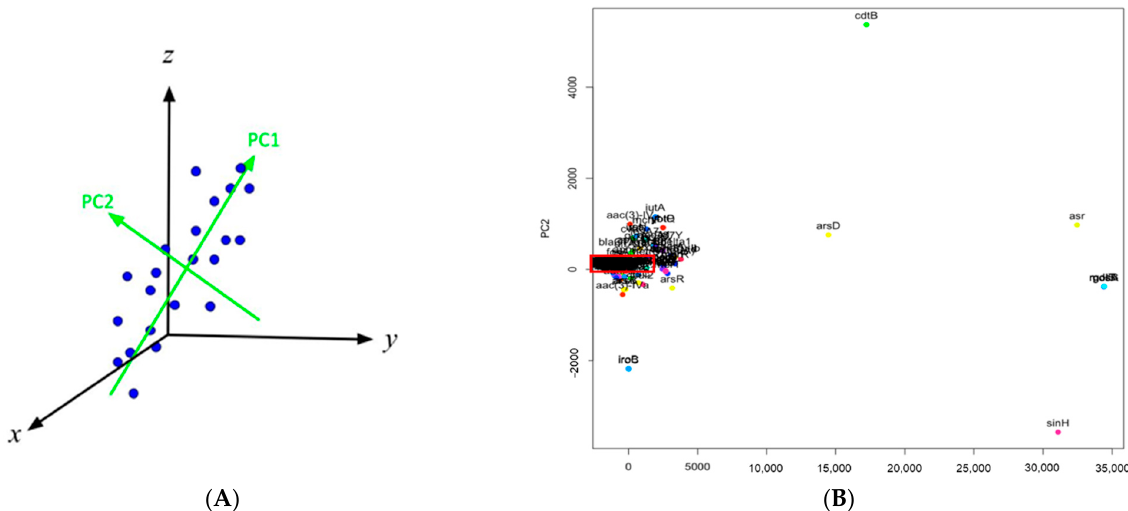
Figure 6. ( A ) illustration on how a three ‐ dimensional space (i.e., x ‐ y ‐ z ) is reduced to a two ‐ dimensional space (i.e., PC1–PC2) with principal component analysis, in which the projections of the data points onto the PC1 direction have the largest variance; ( B ) the high ‐ dimensional dataset for non ‐ outbreak Salmonella spp. was reduced to the two ‐ dimensional PC1–PC2 space so that the genes are visualized. The red rectangle area is for the bulk genes lumped together.